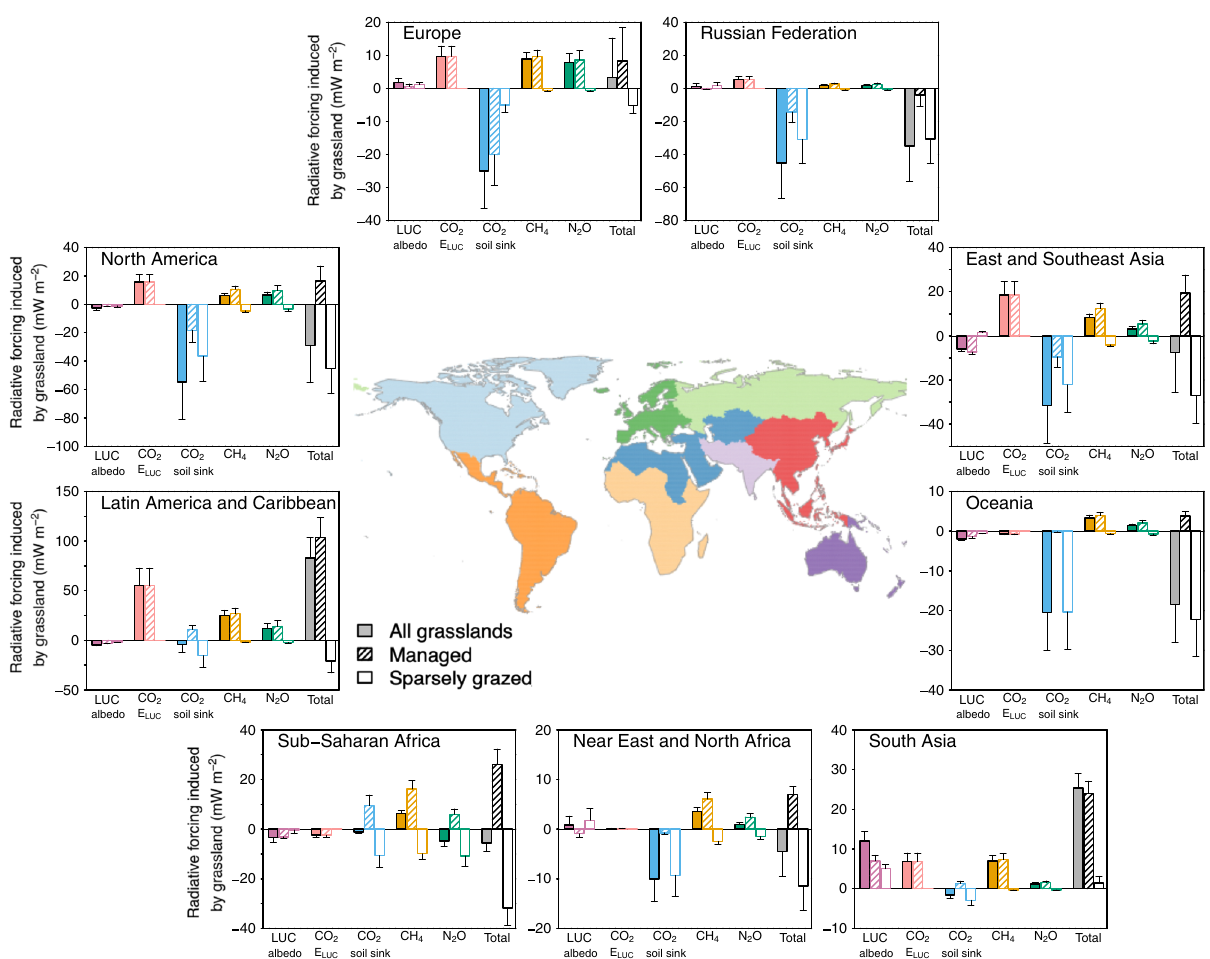
Fig. 5 The contribution of different regions to the global radiative forcing of grasslands. The ‘ Total ’ column is the total contributions of grassland to the global radiative forcing (RF), accounting for the land-use change induced albedo change related to grassland, land-use change emission (CO 2 E LUC ) from deforestation to pasture and conversion of grassland to cropland, and the three grassland GHG fl uxes (CO 2 soil sink, CH 4 and N 2 O). The RF of each component is further divided for managed and sparsely grazed grasslands, and is shown as an empty bar outlined in the same colour with (managed grasslands) and without (sparsely grazed grasslands) hatching, respectively. The uncertainties are 1-sigma standard deviation. The vertical-scale of the regional contribution has been adjusted so that the effects can be easily